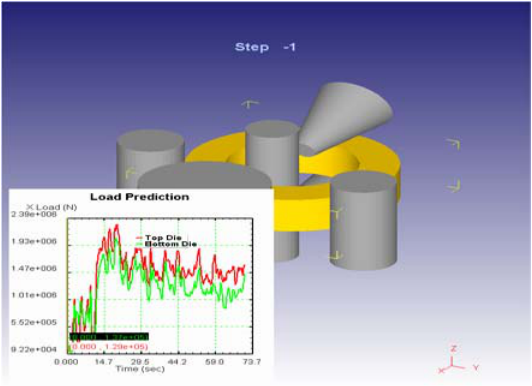
Fig. 3. The stress curve of drive roller and core